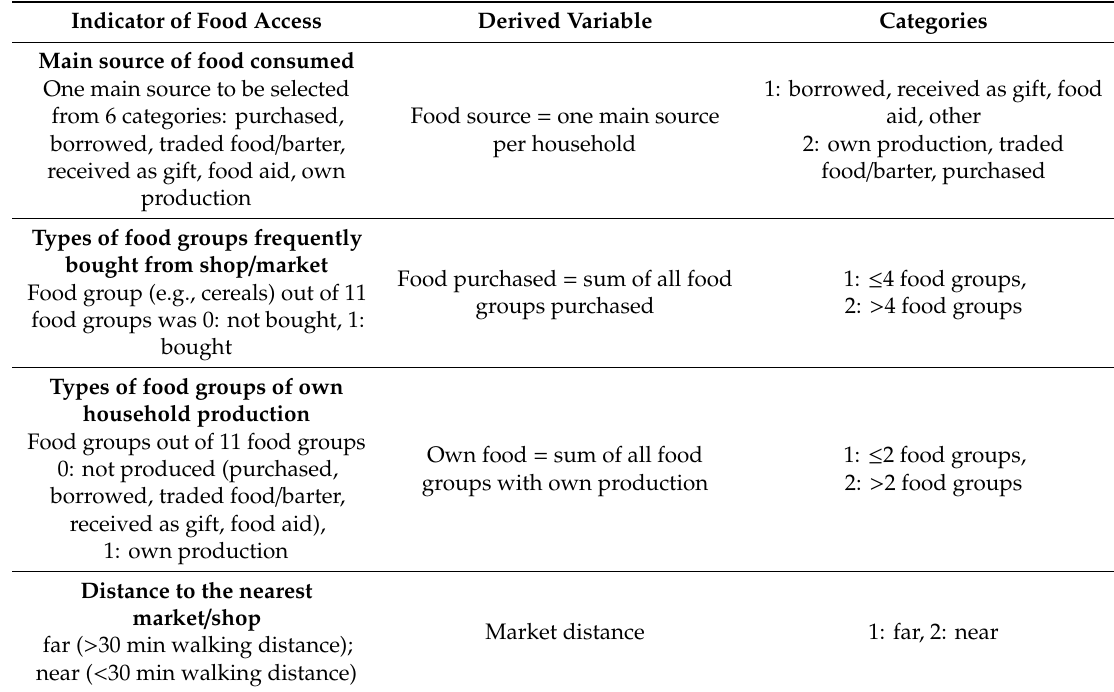
Table 1. Overview of measured indicators for FA and derivation of variables for the composite